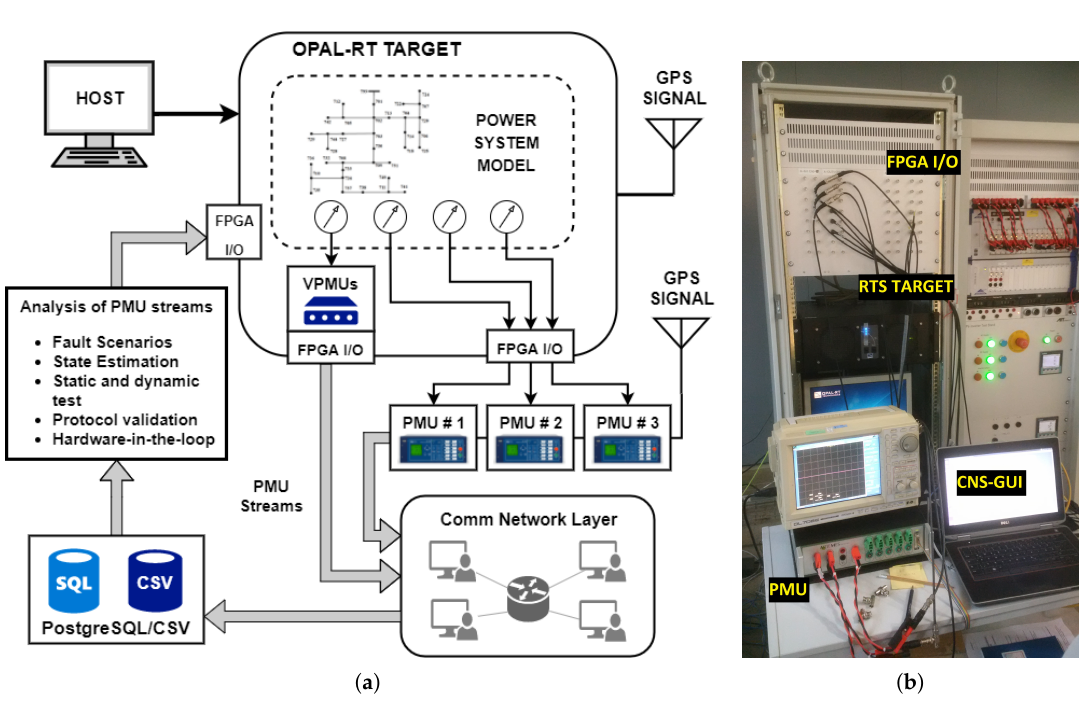
Figure 1. PMU - Real Time Simulation - Hardware-in-the-Loop Testbed (PMU-RTS-HIL): ( a ) schematic connection diagram; ( b ) physical